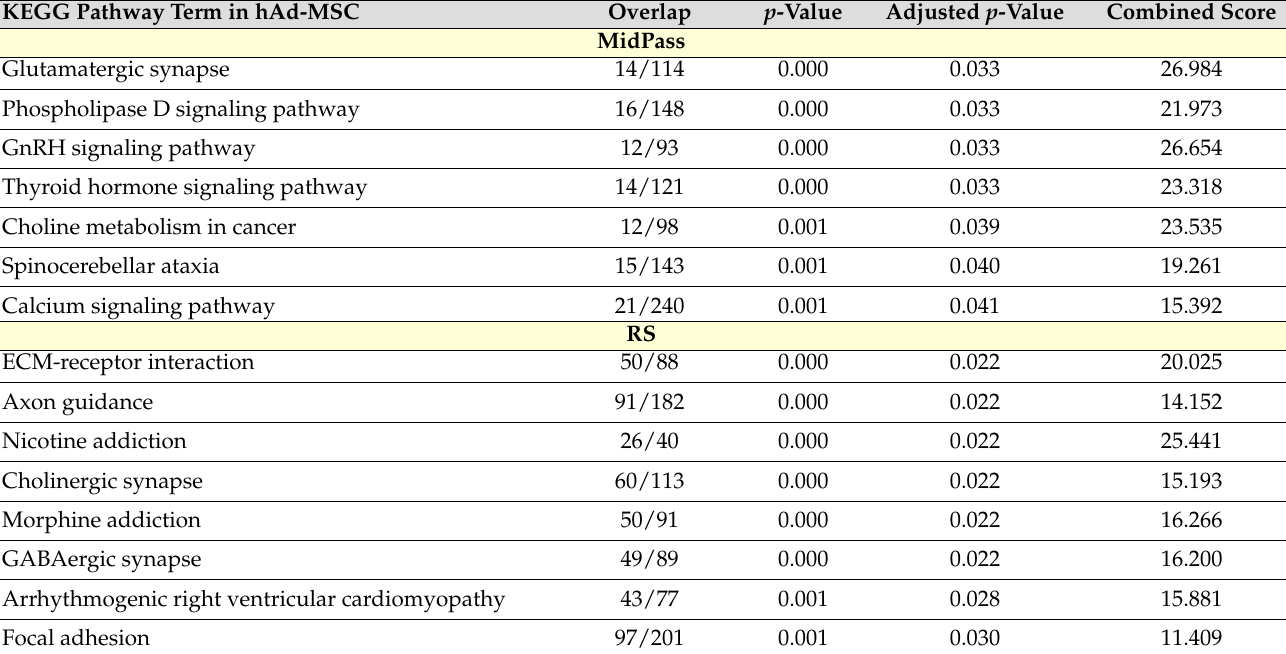
Table 6. Results of pathway enrichment analysis for hAd-MSC after a middle number of passages (MidPass) and replicative senescence (RS). Only the terms for which adjusted p -value reached the statistical significance level of 0.05 are listed. For the description of column names, please refer to